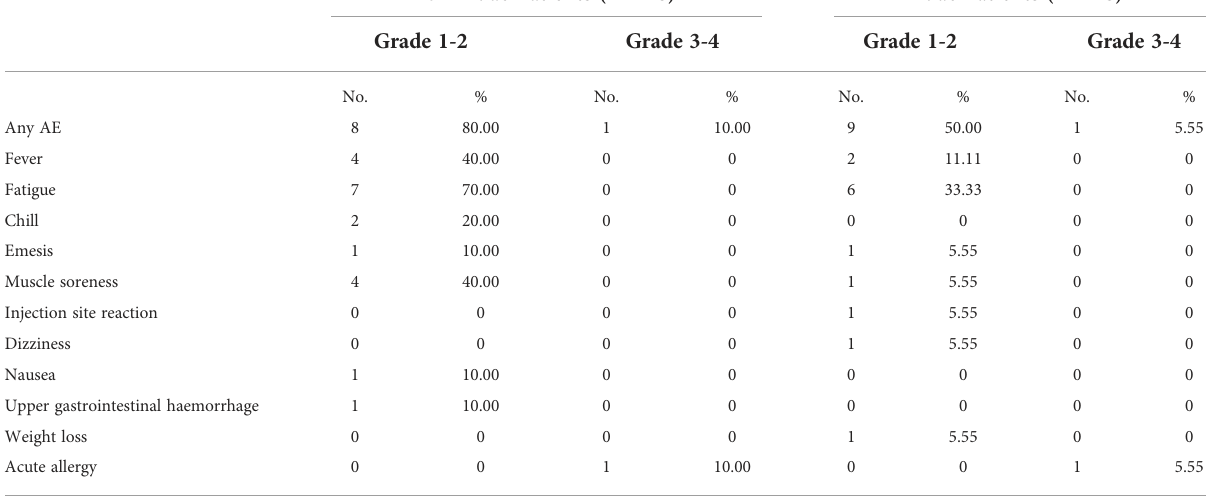
TABLE 2 Treatment related adverse events in all treated patients.